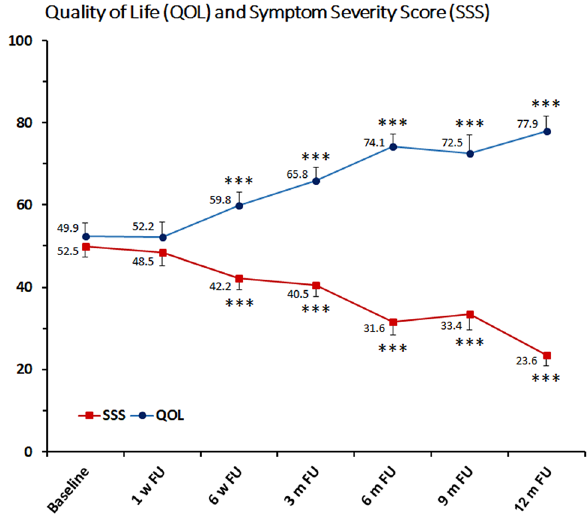
Figure 4. Mean scores of Symptom Severity Scale (SSS) and Health-Related Quality of Life (HRQOL) after ablation of uterine fibroids with US-guided HIFU. Significance levels are indicated by the stars attached (*** indicating p < 0.001) next to average scores. Standard errors were symmetrical (positive error bars shown for HRQOL and negative bars shown for SSS). FU Follow-up, m month, w